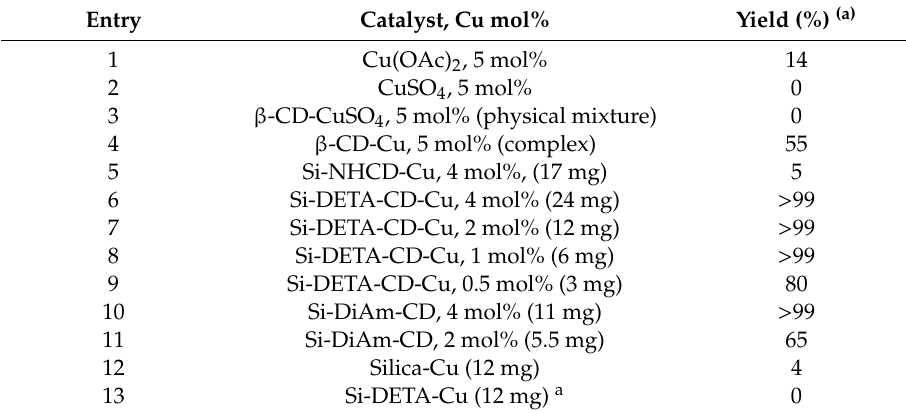
Table 2. Panel test of the CuAAC